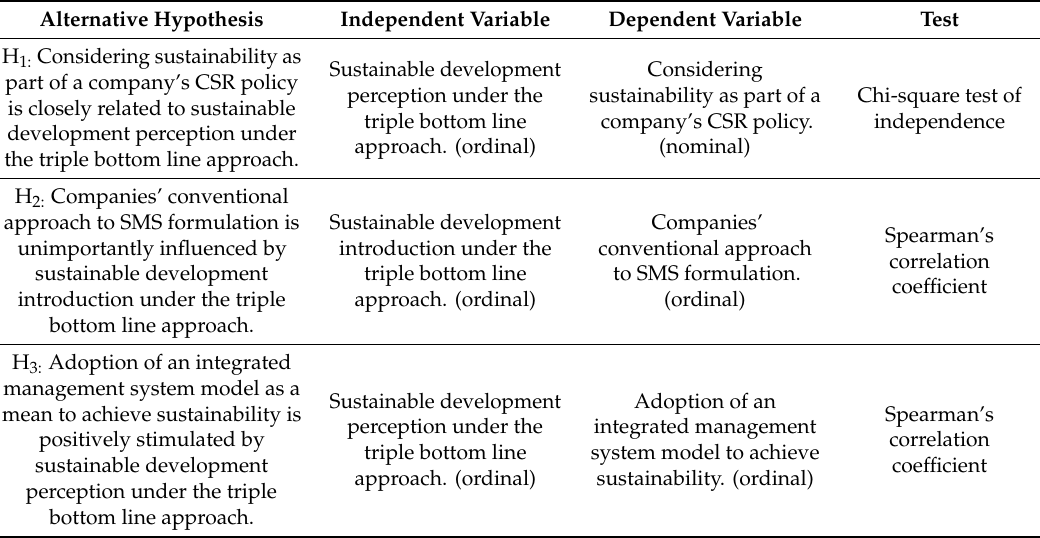
Table 1. Independent and dependent variables and corresponding